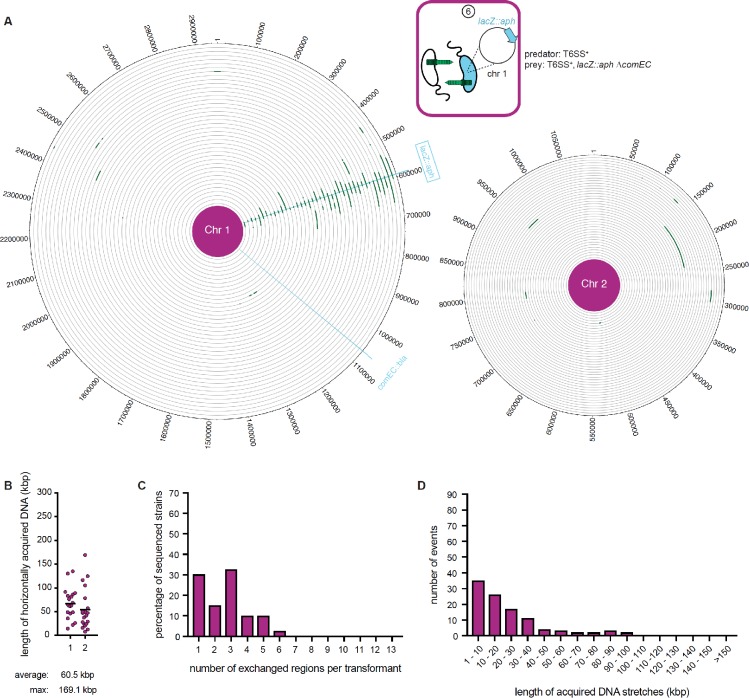
WGS-based quantification of horizontally acquired DNA under condition ⑥.Details as described for Figure 3 with the addition of the map of both chromosomes in panel A.